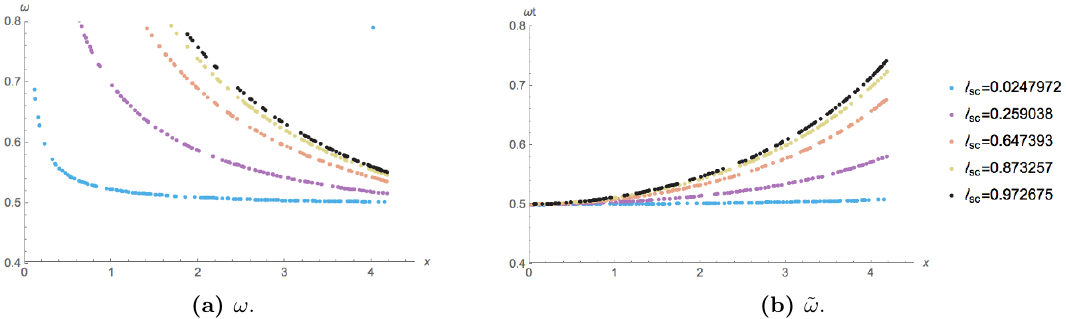
Figure 6. Plots for increasing values of ‘ sc demonstrate that the solution for !; ~ ! for a given x increases with increasing ‘ sc . In the above plot, C = 567 : 605 ; (cid:12) = 2 (cid:25) . The solution for x = (cid:12) is ! = (cid:25)=(cid:12) for all values of ‘ sc . While the solution for x = 0 is ~ ! = (cid:25)=(cid:12) for all values of ‘ sc